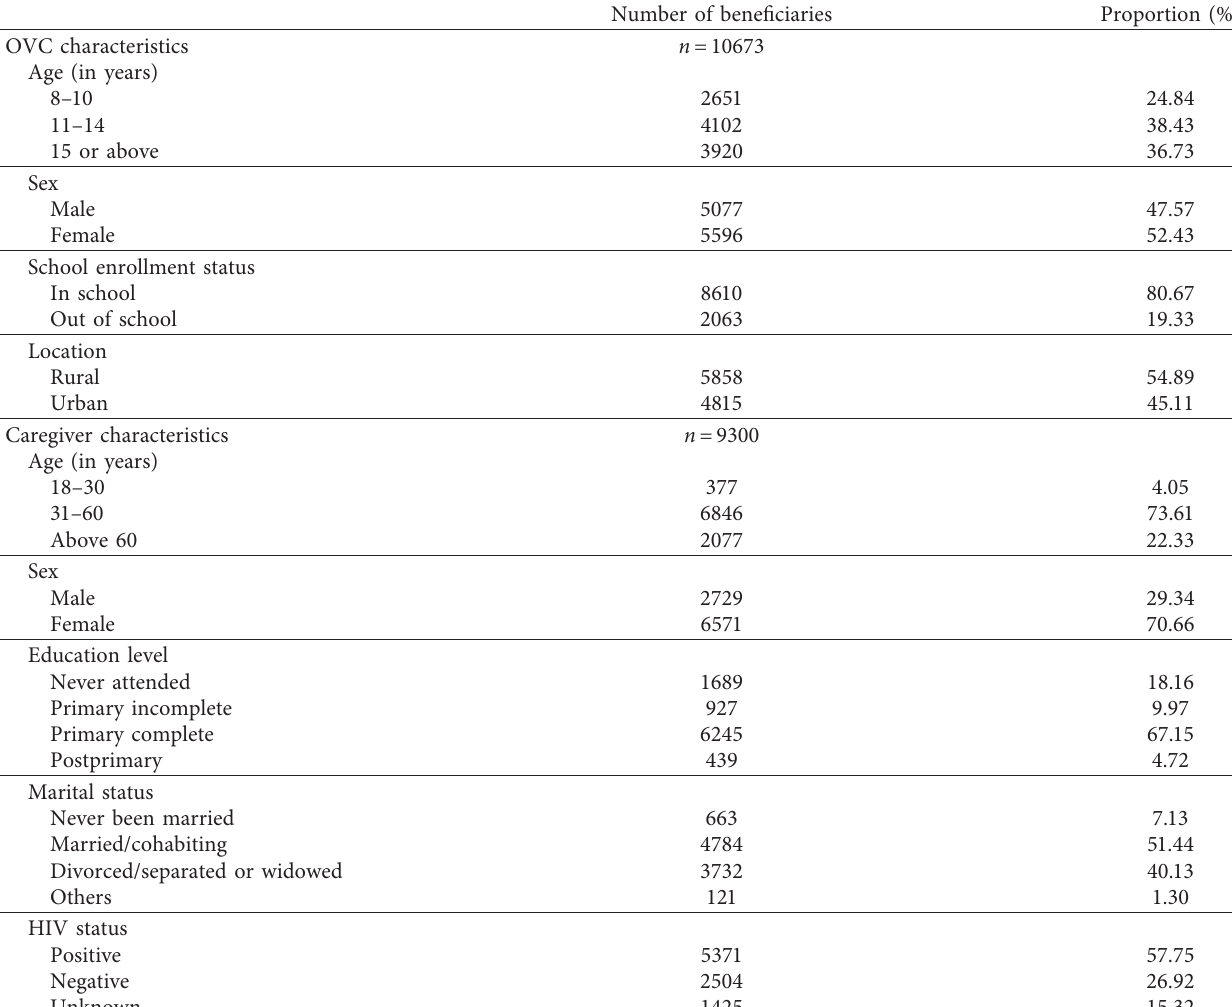
Table 1: Characteristics of all OVCLHIV and their caregivers included in this